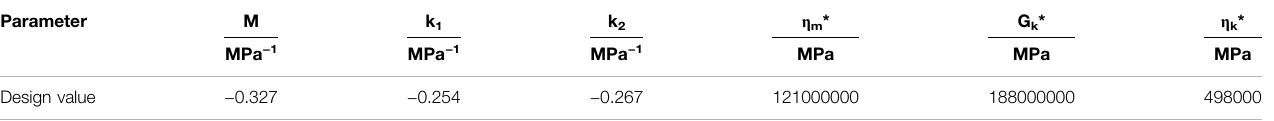
TABLE 5 | Creep parameters of the LUBBY2